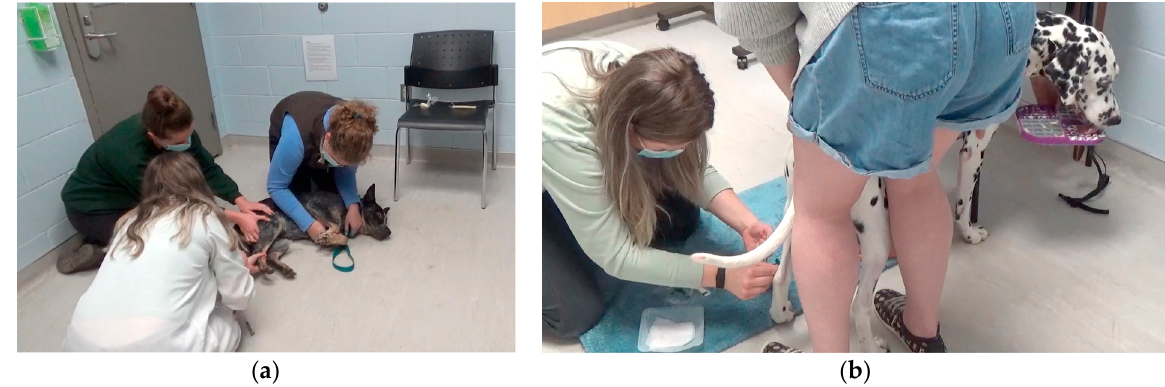
Figure 4. ( a ) Blood collection example for control group and ( b ) intervention group.